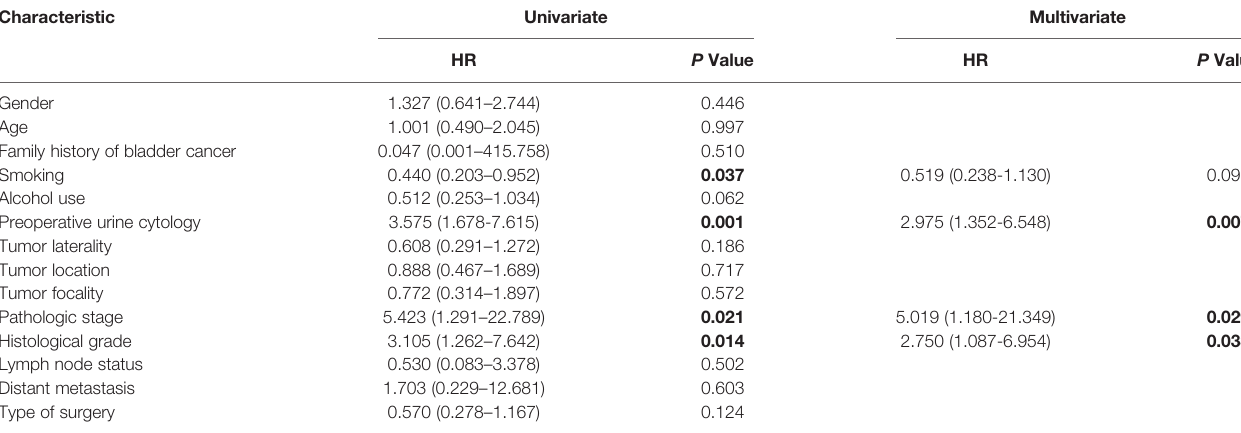
TABLE 4 | Univariate and multivariable Cox regression models predicting intravesical recurrence-free survival in 89 patients treated with RNU for UUT-UC in validation cohort. Characteristic